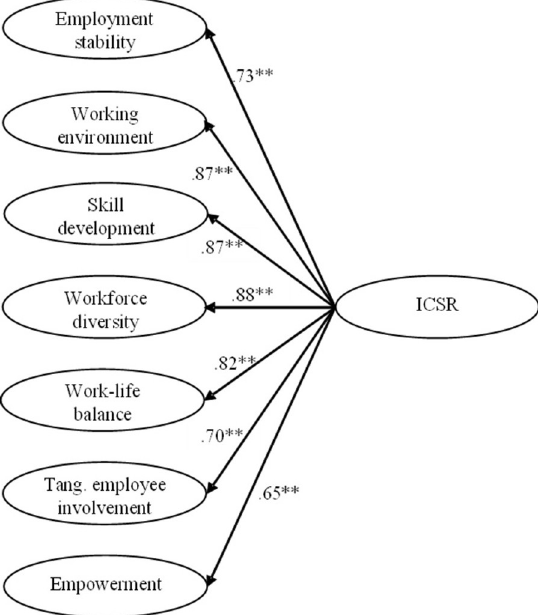
Fig 2. Second-order confirmatory factor analysis for ICSRQ. Note . Standardized loadings. �� p < .01.